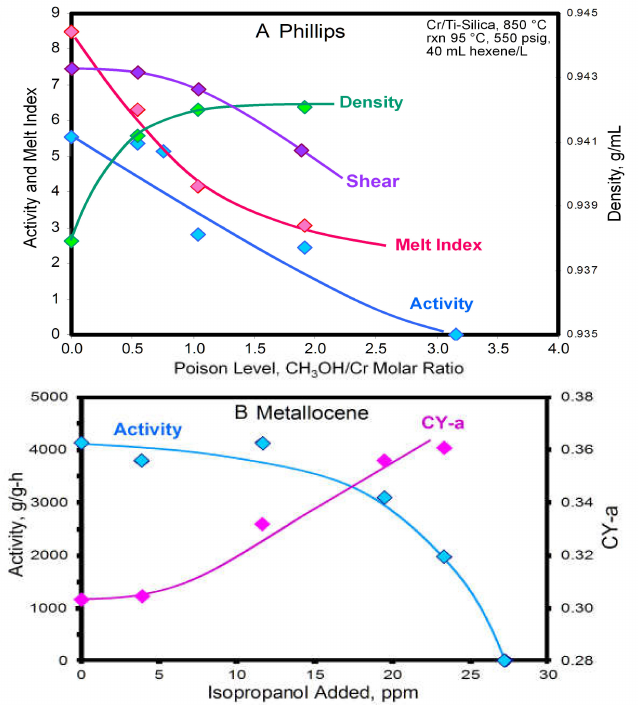
Figure 8. Effect of adding alcohol to the reactor. (( A ), above): methanol to a Phillips catalyst. (( B ), below): isopropanol to a metallocene on fluorided